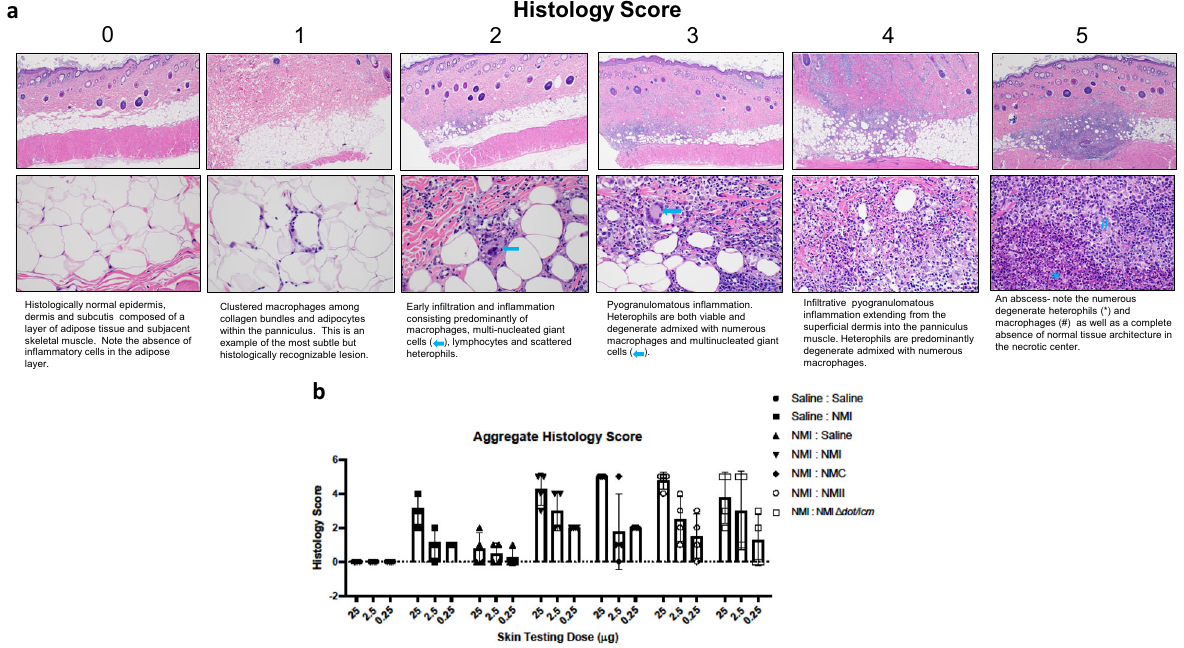
Fig. 8 The post-vaccination hypersensitivity response is characterized by guinea pig skin in fl ammation and abscess formation. a Micrographs of skin biopsies from individual skin test sites that were stained by hematoxylin and eosin and scored for lesion severity. Upper and lower micrographs are at 40X and 400X magni fi cation, respectively. b Aggregate histology scores are presented as individual scores with mean (bars) and standard deviation (error bars) using the scoring schematic as described in ( a ).